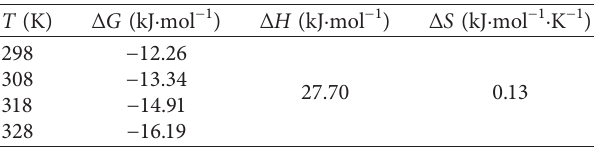
Figure 10: Thermodynamic study of adsorption of Congo red on fish bone powder. Table 4: Thermodynamic parameters for the adsorption of Congo red on